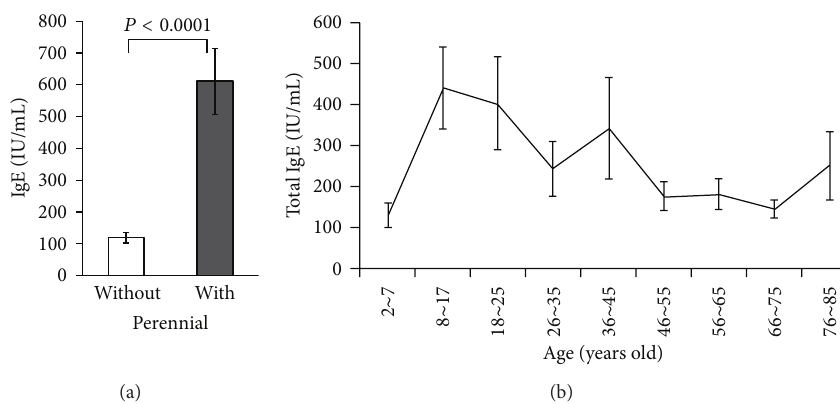
Figure 2: (a) Total serum IgE levels were significantly elevated in 137 patients sensitized to both perennial allergens and spring pollens ( 609 ± 104 IU/mL) compared to 98 patients sensitized only to spring pollens ( 118 ± 16 IU/mL; 𝑃 < 0.0001 , Mann-Whitney 𝑈 test). (b) Variation of eosinophil cell count with age. This parameter was highest in children 9–17 years of age.